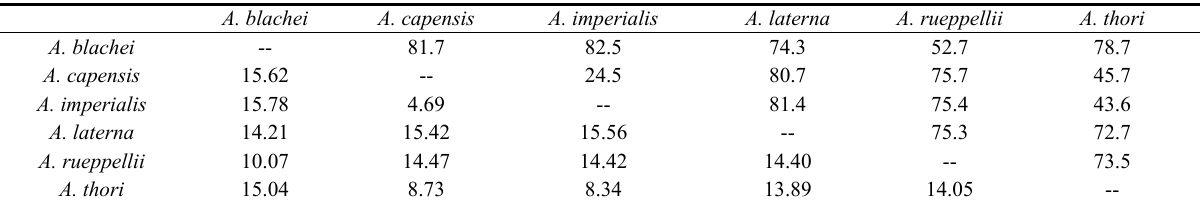
Table 5. – Mean genetic distances (%) and numbers of base differences for COI of species pairs of Arnoglossus below and above the diagonal,